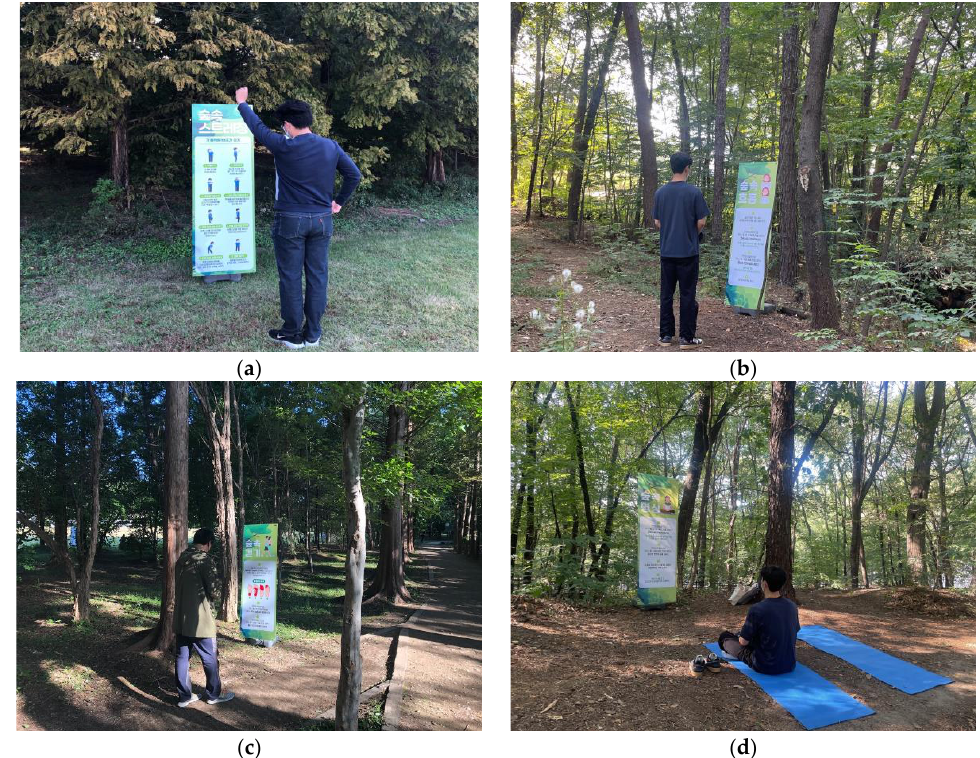
Figure 3. The self-guided forest healing program. ( a ) stretching; ( b ) diaphragmatic respiration; ( c ) walking; ( d ) meditation.